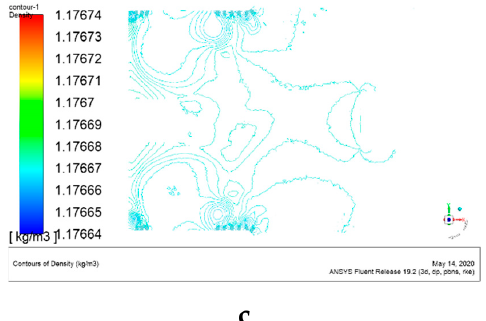
Figure 5. Contour maps of the fluid density in the beam expanding system: ( a ) contour map for plan A; ( b ) contour map for plan B; ( c ) contour map for plan C.